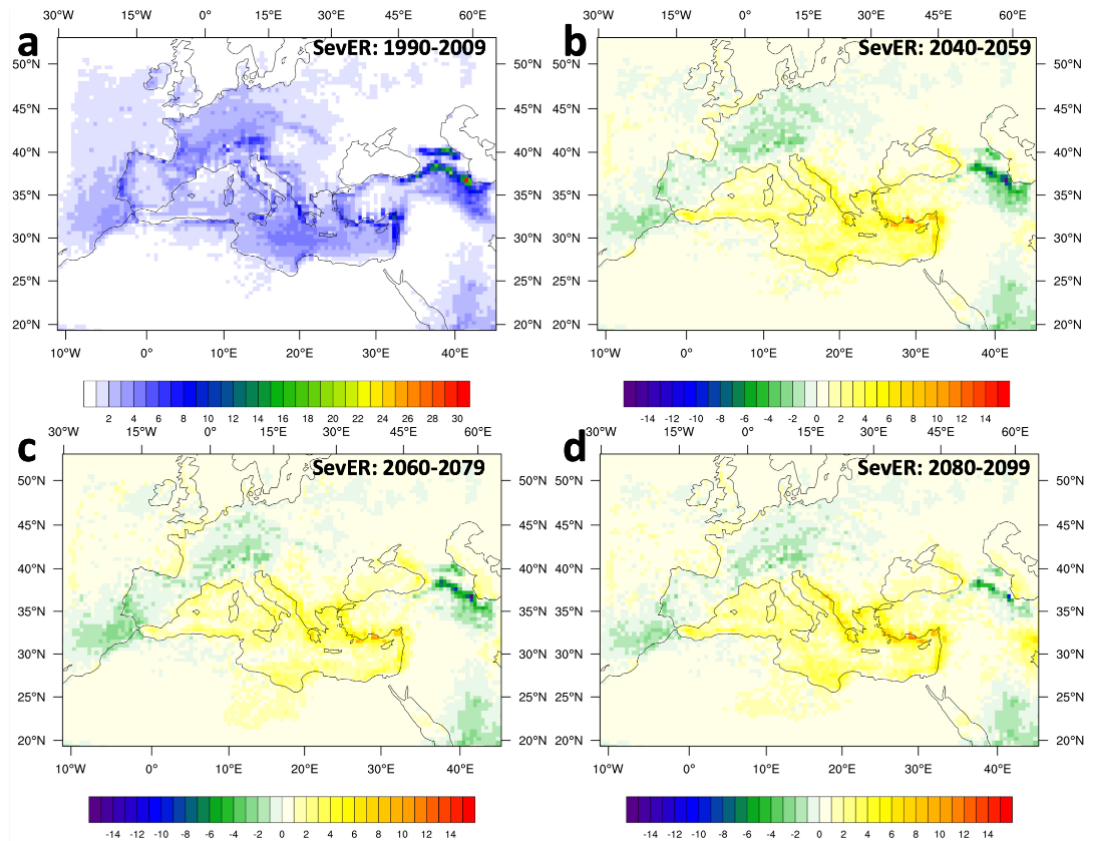
Figure 6. ( a ) Annual average number of days with CAPE ≥ 100 J/kg AND 0 –6 km SHEAR ≥ 15 m/s AND convective precipitation rate > 0 mm/h (SevER) for 1990–2009, ( b ) changes in average number of days with SevER for 2040–2059, ( c ) changes in average number of days with SevER for 2060–2079, ( d ) changes in average number of days with SevER for 2080–2099.